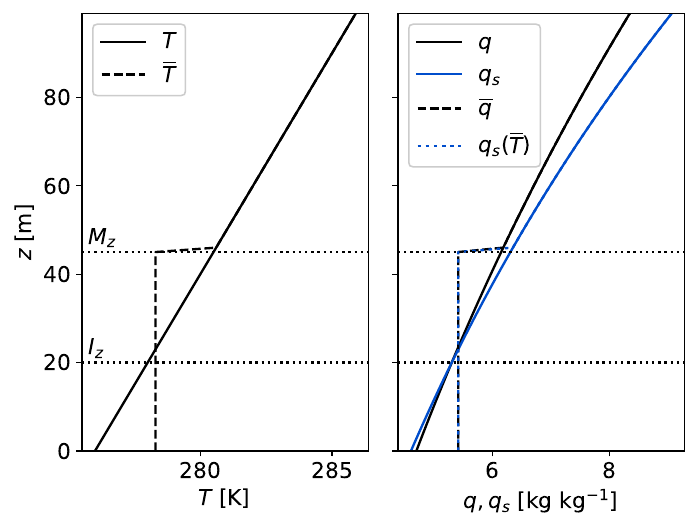
Figure 3. Illustration of M z using linear temperature and relative humidity profiles. M z is deeper than I z due to the super saturation within the fog layer. In stable conditions, M z ∼ 2 I z (Section